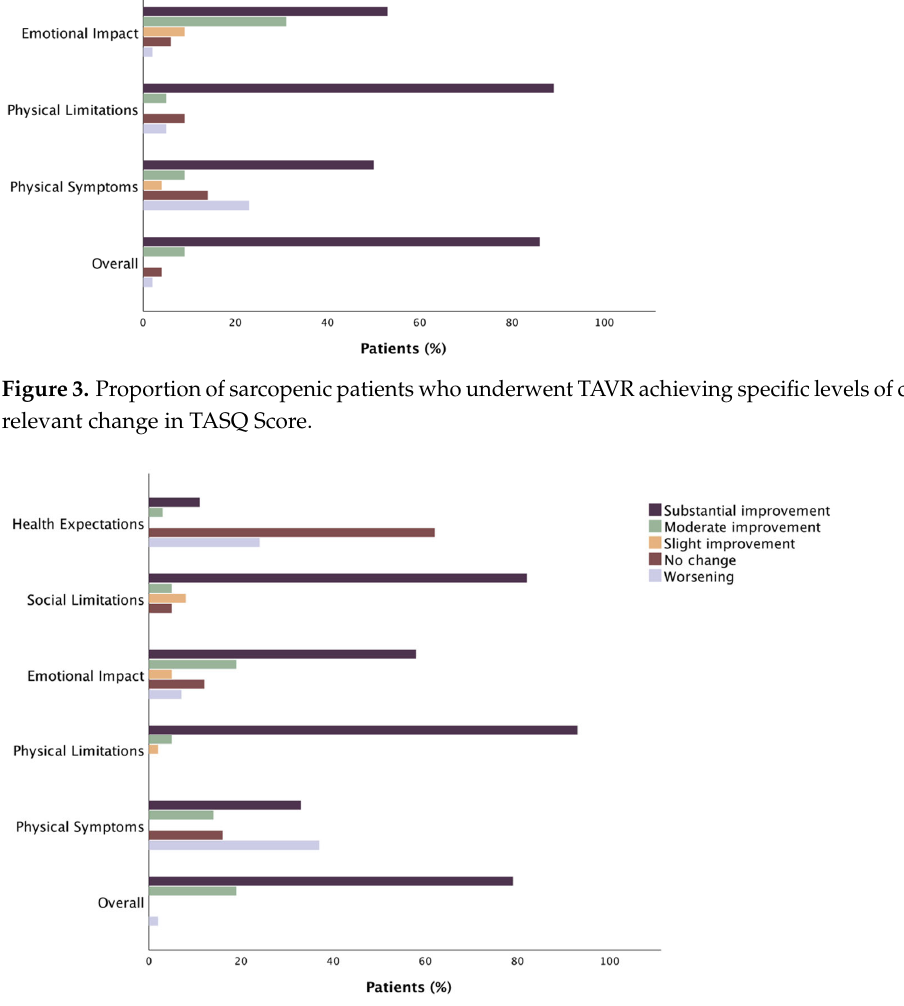
Figure 4. Proportion of non-sarcopenic patients who underwent TAVR achieving specific levels of clinically relevant change in TASQ Score. Table 3. Within-group change in TASQ in sarcopenic vs. non-sarcopenic patients at three-month